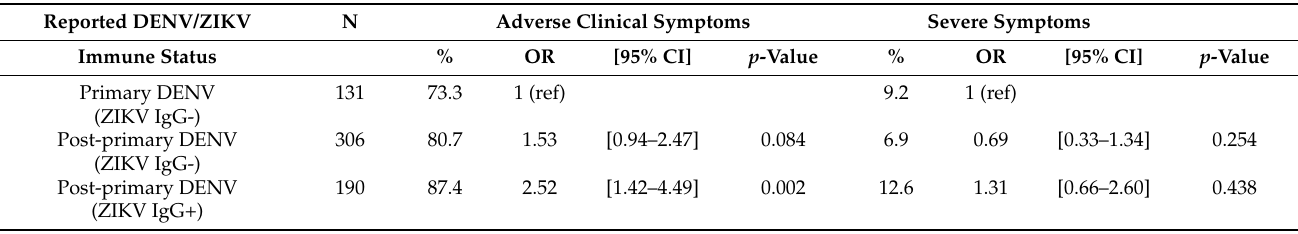
Table 1. Clinical manifestations associated with primary DENV infections (ZIKV IgG-), post-primary DENV infections (ZIKV IgG-) and post-primary DENV infections (ZIKV IgG+). Adverse clinical symptoms: dengue warning signs or severe symptoms. OR: odds